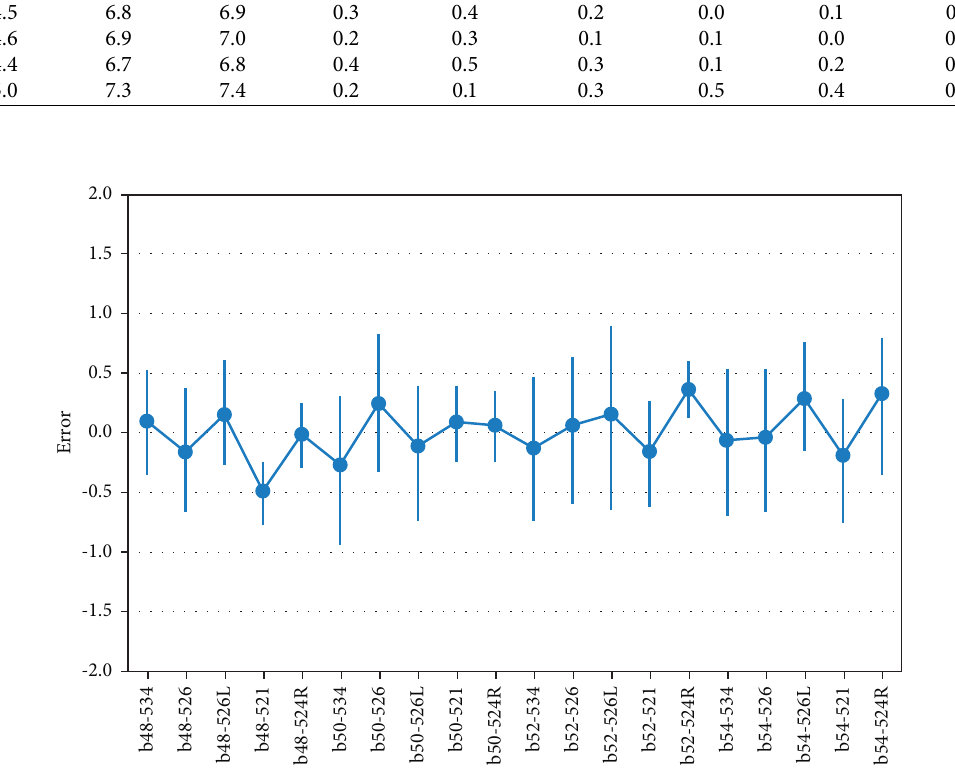
Figure 10: Error distribution of OD